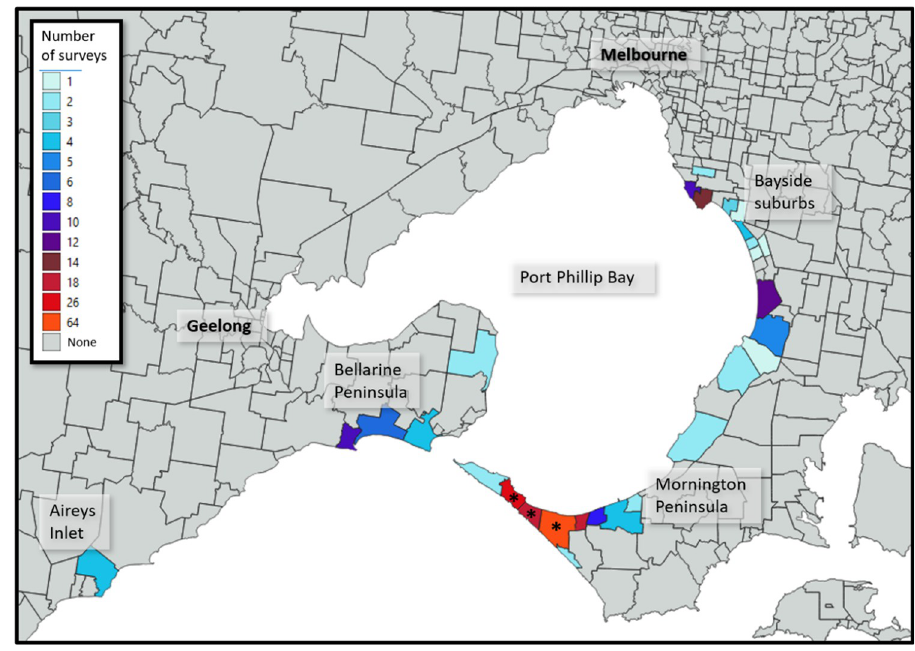
Fig 1. Map of affected area, illustrating the number of property surveys conducted by suburb. An asterisk ( � ) is shown on suburbs where repeat sampling was undertaken. N.B. Geographical boundaries are not available by postcode and some postcodes contain more than one suburb. Incorporates Geoscape Administrative Boundaries reprinted from https://data.gov.au/dataset/ds-dga-af33dd8c-0534-4e18-9245-fc64440f742e/distribution/dist-dga-4d6ec8bb-1039-4fef- aa58-6a14438f29b1/details?q= under a CC BY license, with permission from the Commonwealth of Australia, original copyright